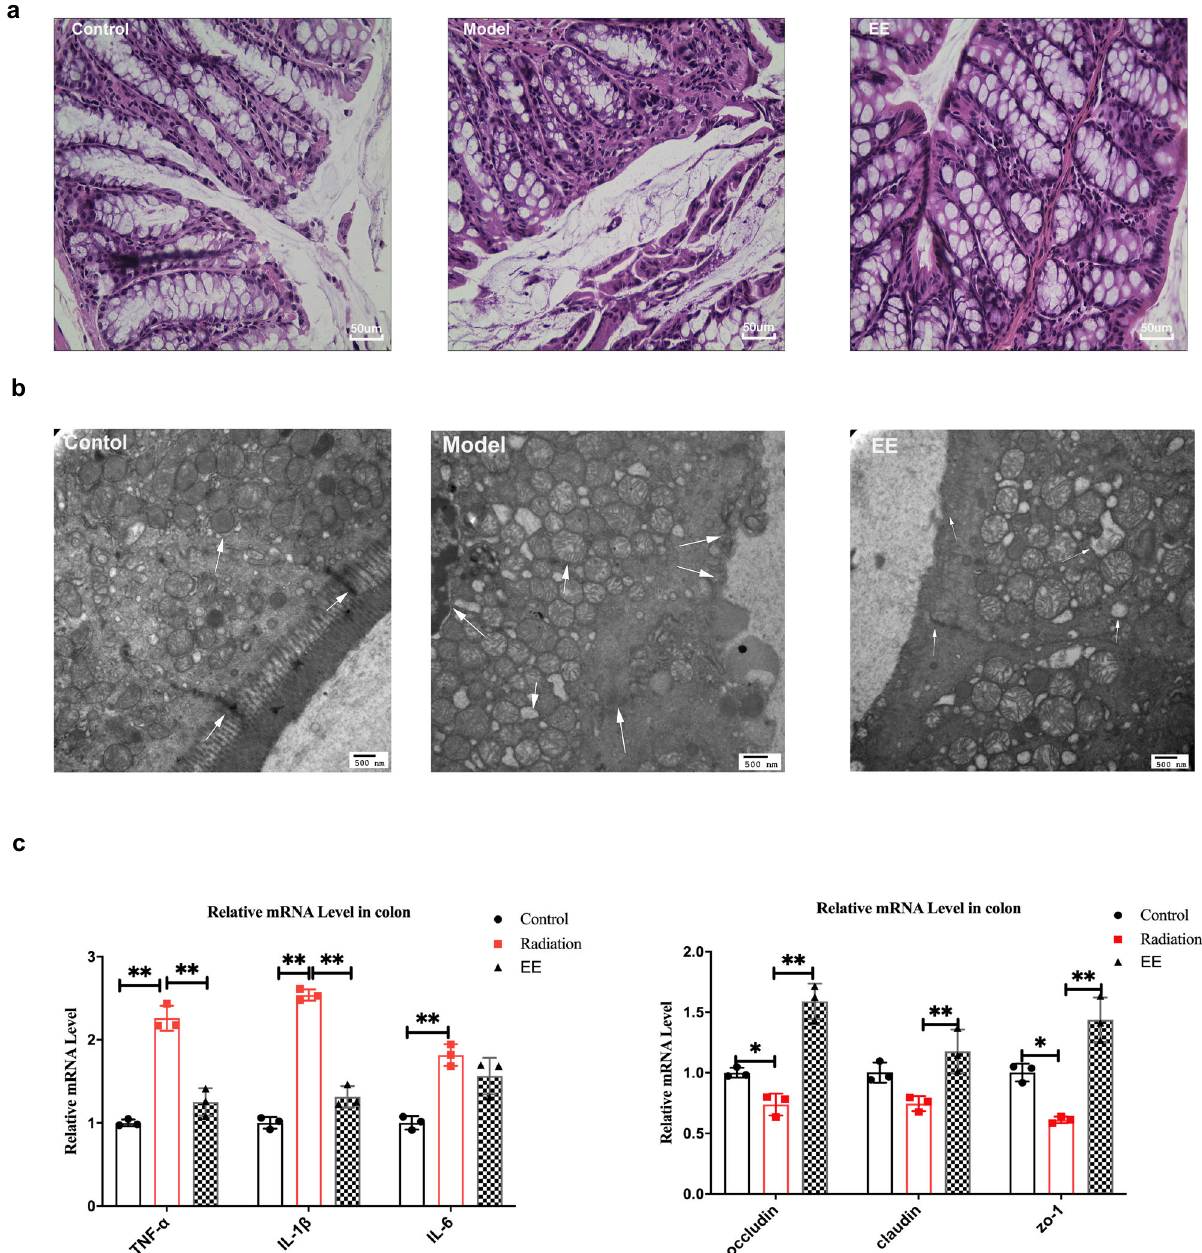
Fig. 2 EE supplementation prevented colonic mucosa barrier impairment and in fl ammation in irradiated mice. a The result of H&E staining on colon (Scale bar = 50um). b The ultrastructural features in colon (Scale bar = 500 nm). c The mRNA expression of in fl ammatory cytokines and tight junction proteins in colon of mice. (Values are expressed as the mean ± SD ( n = 5). Statistical analyses were conducted using the one-way ANOVA followed by Tukey ’ s post hoc test, * p < 0.05, ** p <